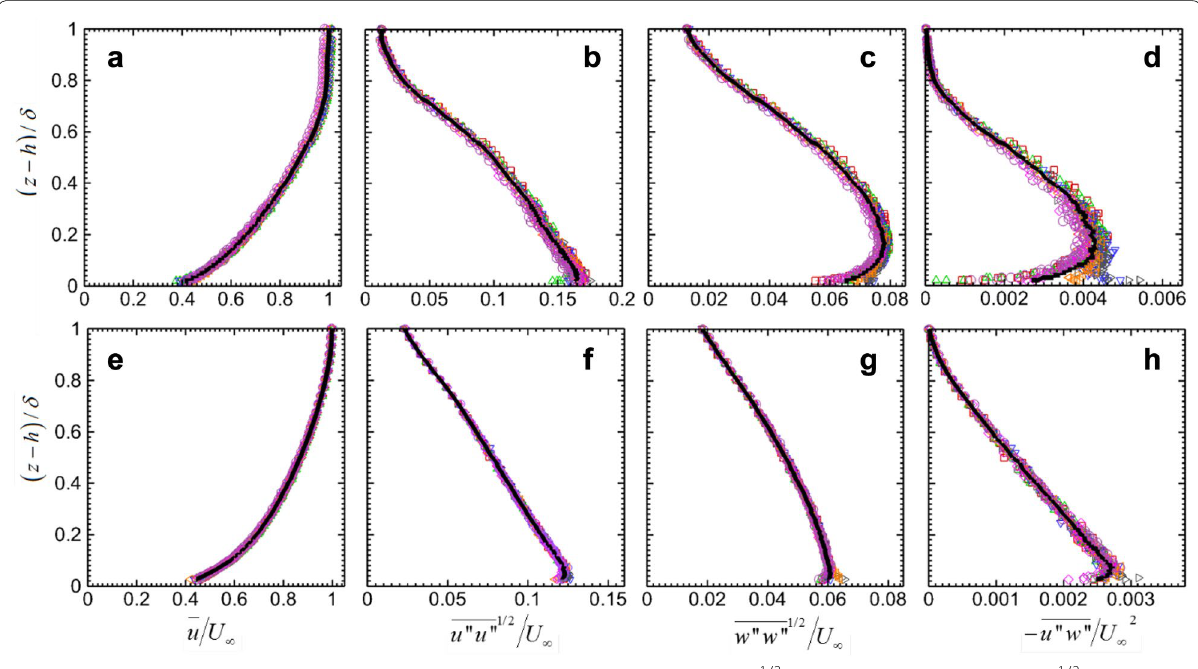
Fig. 4 Dimensionless vertical profiles of mean velocity ¯ u , streamwise fluctuating velocity u ′′ u ′′ momentum flux u ′′ w ′′ measured at different locations over the rib‑type array AR ( (cid:874) ); P4 ( (cid:1725) ); P5 ( (cid:1735) ); P6 ( (cid:442) ); P7 ( (cid:443) ). Dark solid line is spatially average